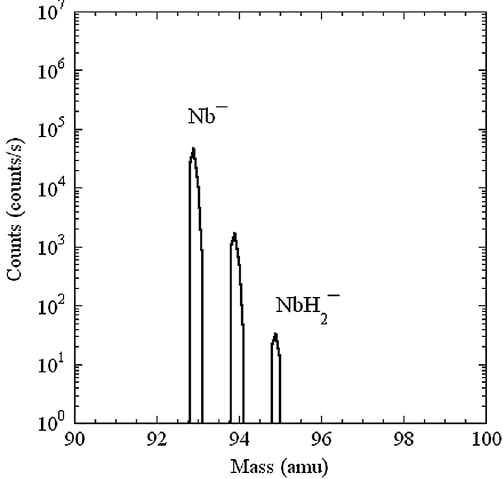
FIG. 22. SIMS mass spectrum of heat treated sample L10.